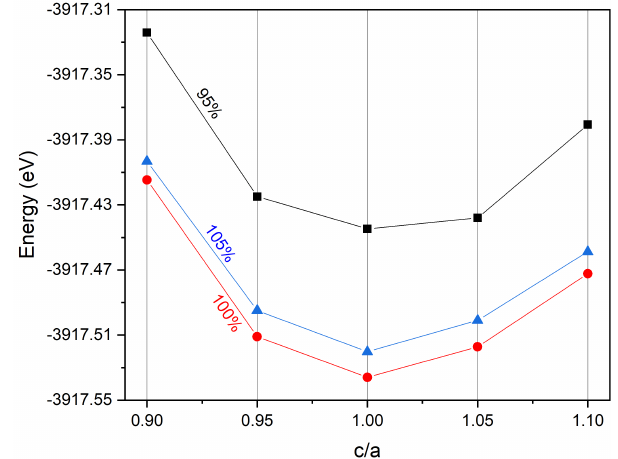
Figure 6. The total energy of Ti 2 MnAl compound with different unit cell volume under tetragonal deformation of different c/a